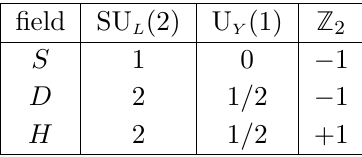
Table 1 . Particle content and charge